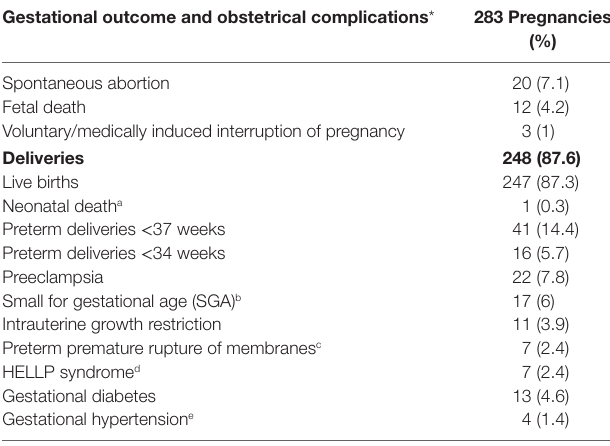
Table 2 | Outcome of 283 pregnancies in 200 patients during the